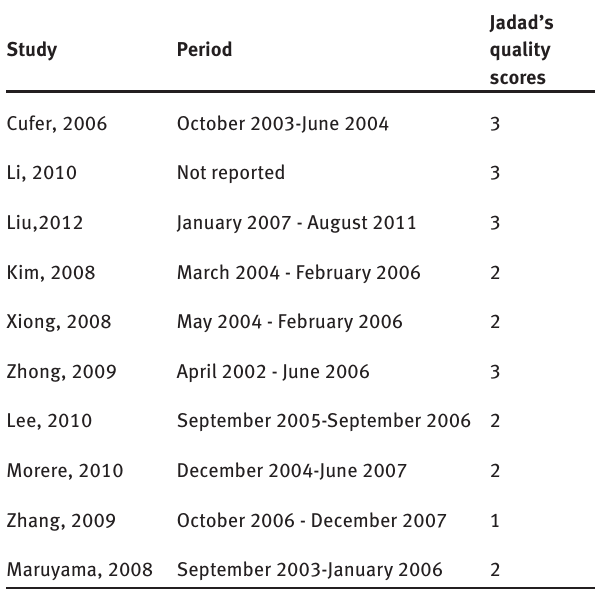
Table 2: Quality assessment of included